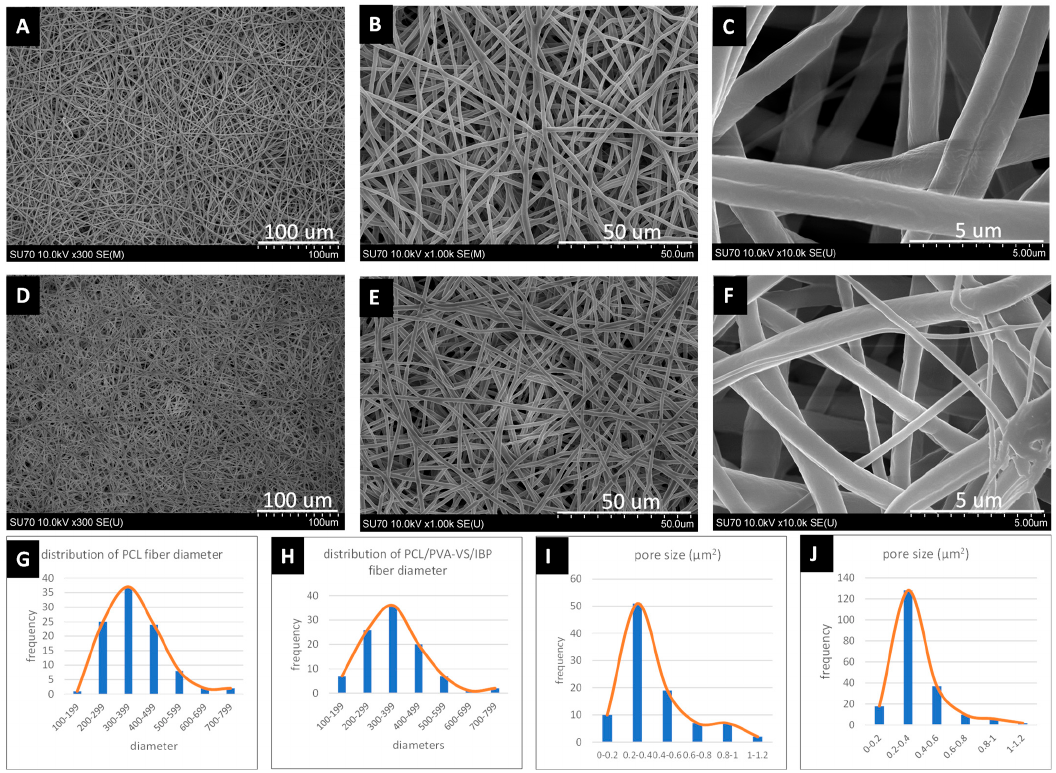
Figure 1. Surface characterization of PCL and IBP ‐ coated nanofibrous membranes. ( A ) PCL nano ‐ fibrous membranes, ×300; ( B ) PCL nanofibrous membranes, ×1.00k; ( C ) PCL nanofibrous mem ‐ branes, ×10k; ( D ) IBP ‐ coated nanofibrous membranes, ×300; ( E ) IBP ‐ coated nanofibrous membranes, ×1.00k; ( F ) IBP ‐ coated nanofibrous membranes, ×10k. SEM images show morphologies of samples with random fibrous orientation and variably sized pores. Average diameter of IBP ‐ coated mem ‐ branes is not significantly different from uncoated PCL membranes, and pore sizes of IBP ‐ coated membranes were also similar to uncoated PCL membranes. Distribution of fiber diameters for PCL ( G ) and IBP ‐ coated ( H ) nanofibrous membranes. Pore sizes for PCL ( I ) and IBP ‐ coated ( J ) nano ‐ fibrous membranes.